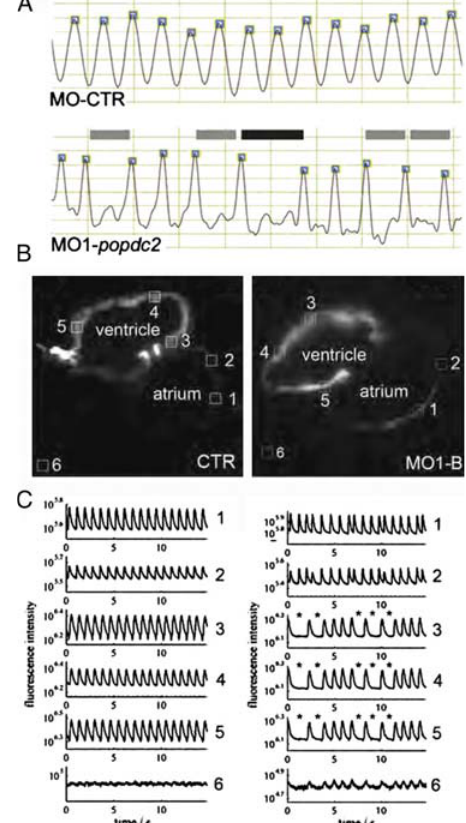
Figure 3. Analysis of cardiac arrhythmias in zebrafish popdc2 morphants. (A) Ventricular contractions are regular in control animals (CTR) but display 2:1 and 3:1 secondary AV block in popdc2 morphants (MO1). (B, C)